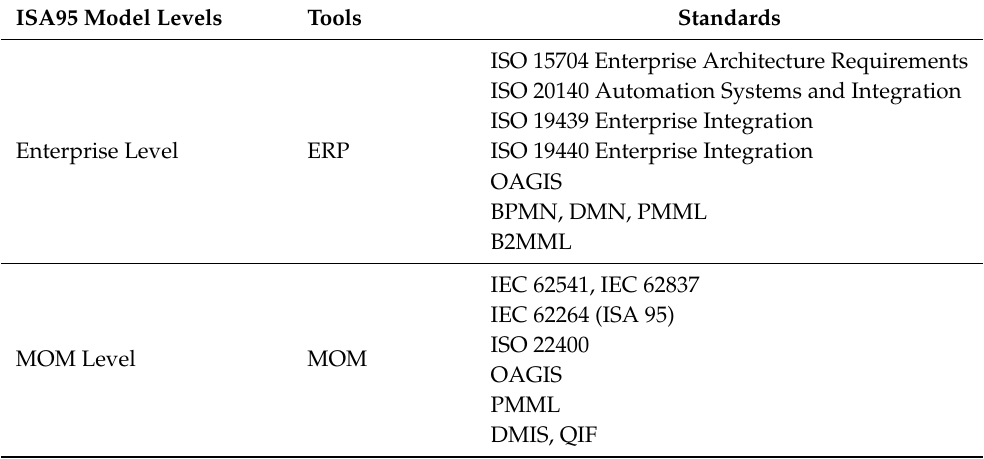
Table 1. Standards aligned to the ISA95